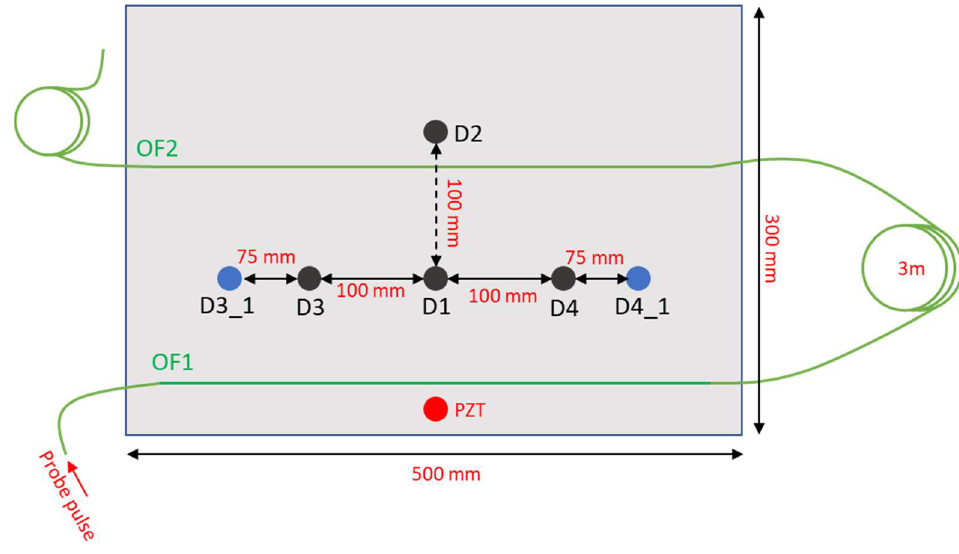
Figure 7. Aluminum plate used for the experiments, with the blue circles representing the positions used for testing but not for training. Table 2. Results of SVM testing with damage positions different from the ones used for training. Real Damage